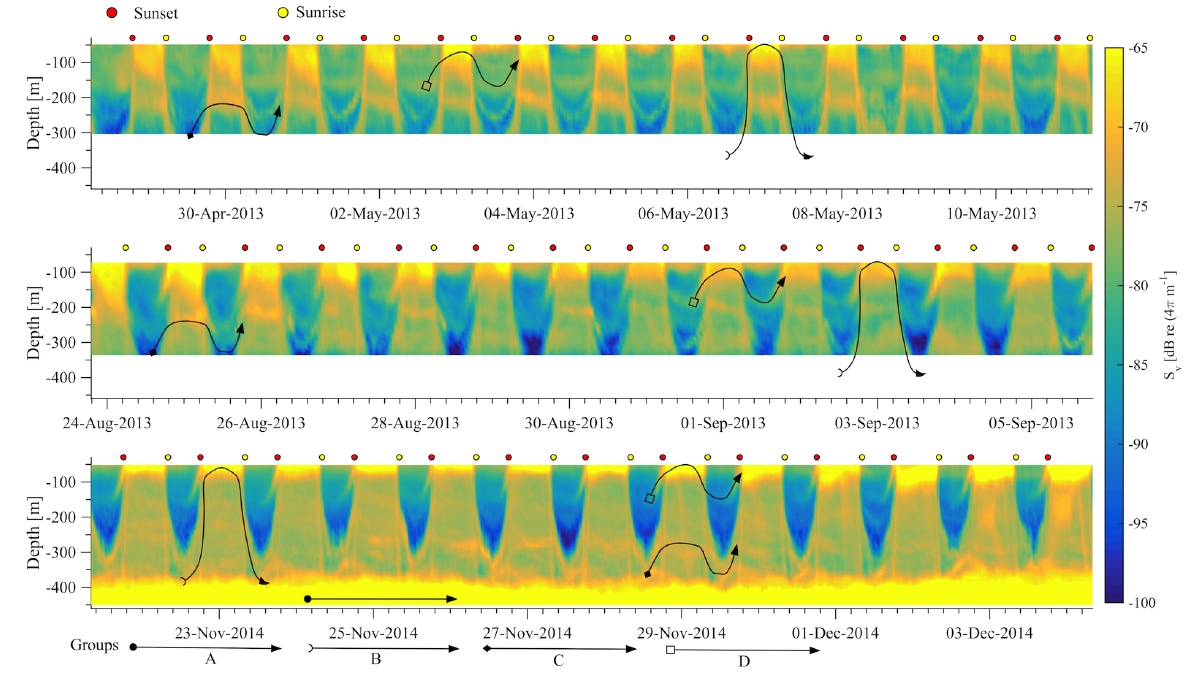
Figure 7. Hand drawn trails of S v attributed to groups of planktonic and micronektonic